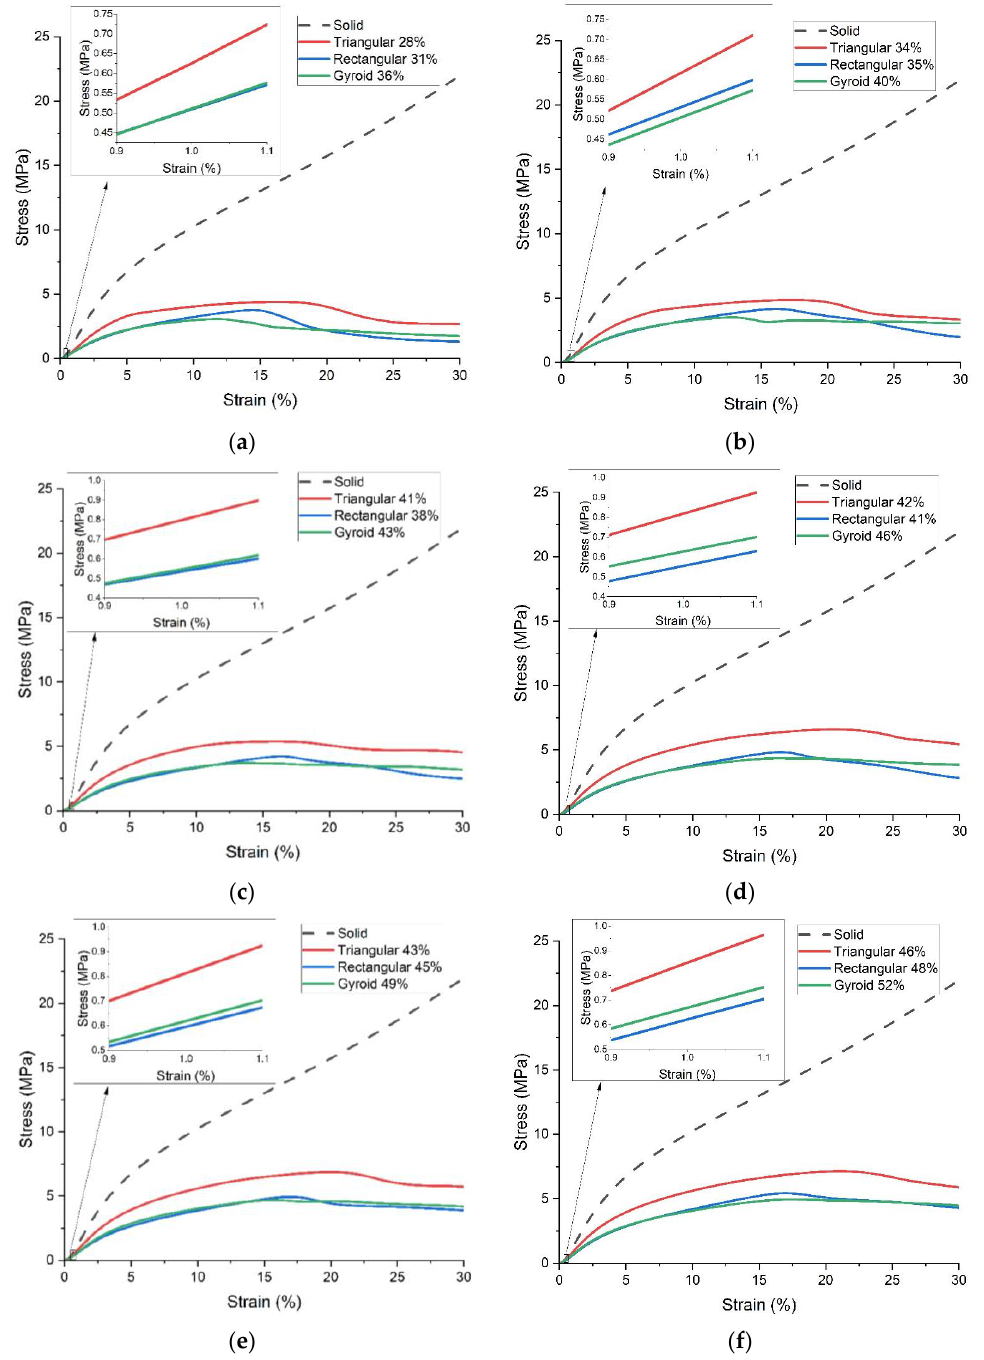
Figure 11. Comparison of compressive strength of different infill-pattern standard specimens grouped by mass. ( a ) 1.6 g; ( b ) 1.7 g; ( c ) 1.8 g; ( d ) 1.9 g; ( e ) 2.0 g; ( f ) 2.1 g.